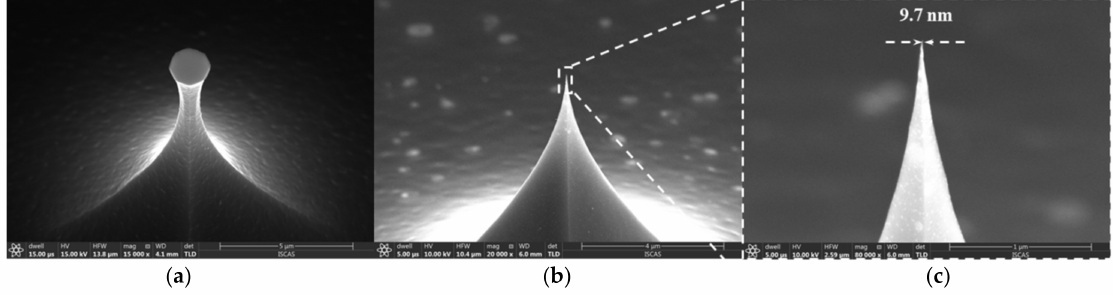
Figure 4. Si nano-tip profile: after etching ( a ) and after oxidation sharpening ( b , c